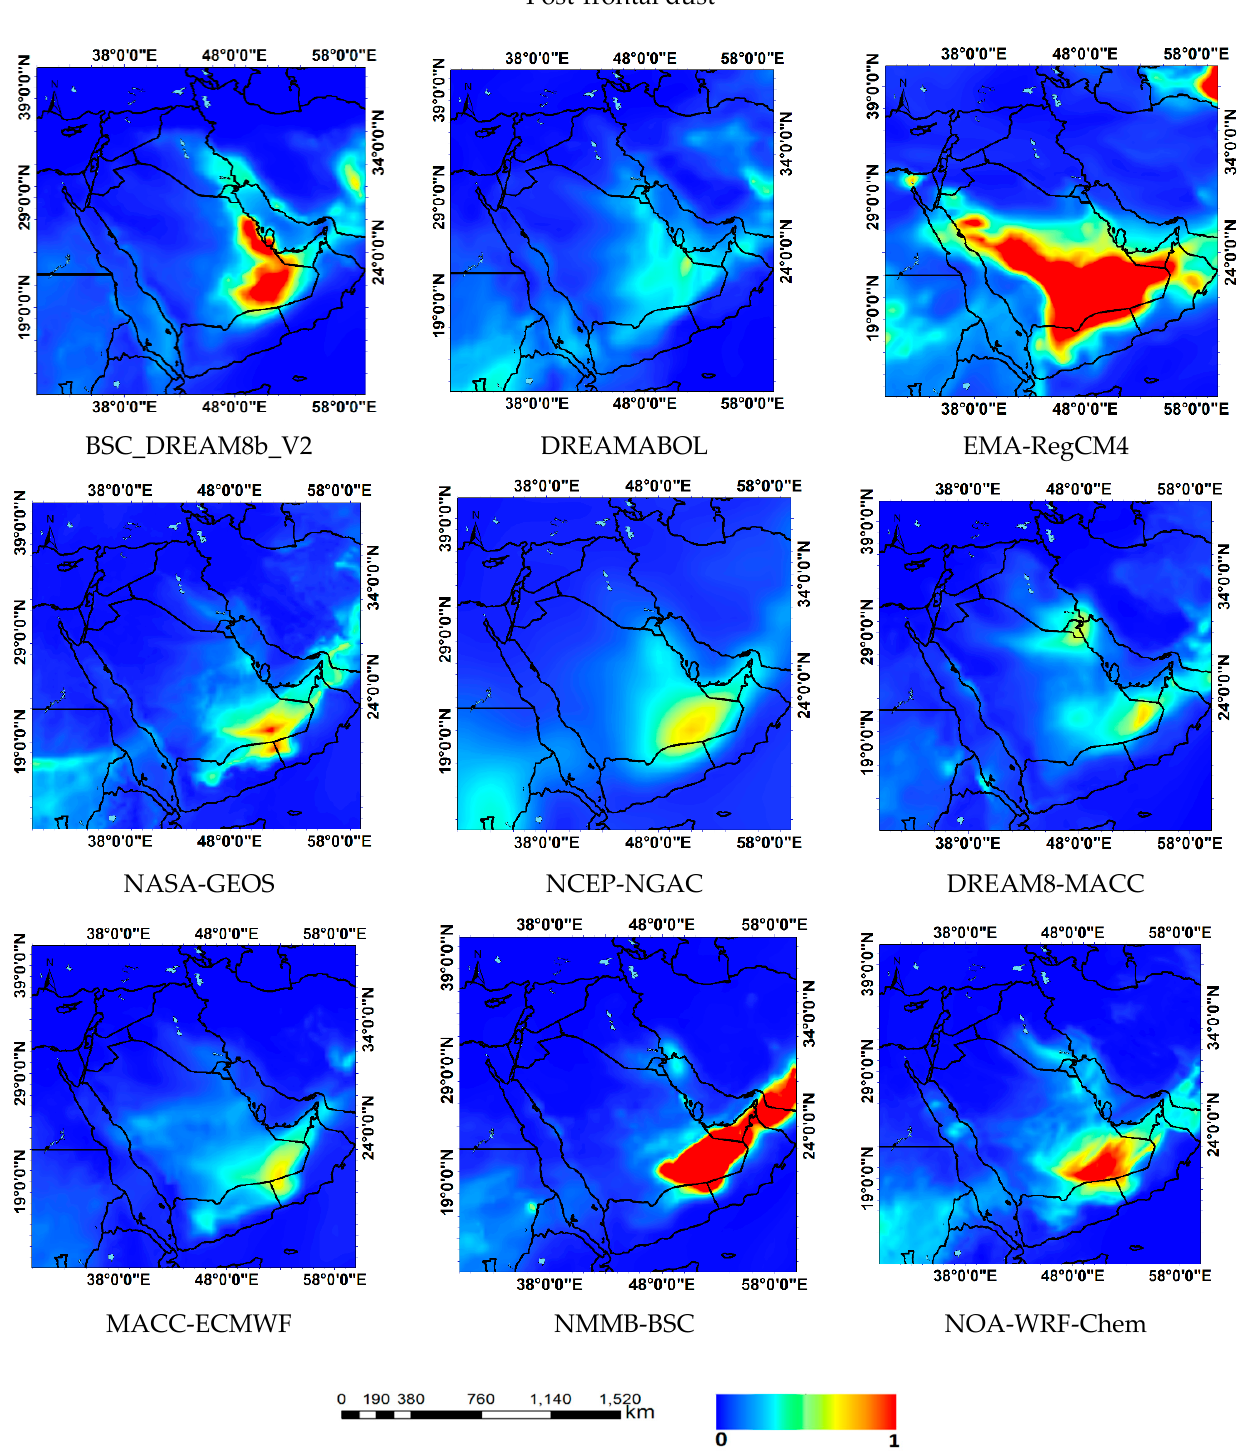
Figure 5. Spatial distribution of AOD forecasts from the nine examined models at 07:00 UTC on 18 February 2017 (post- frontal dust storm).